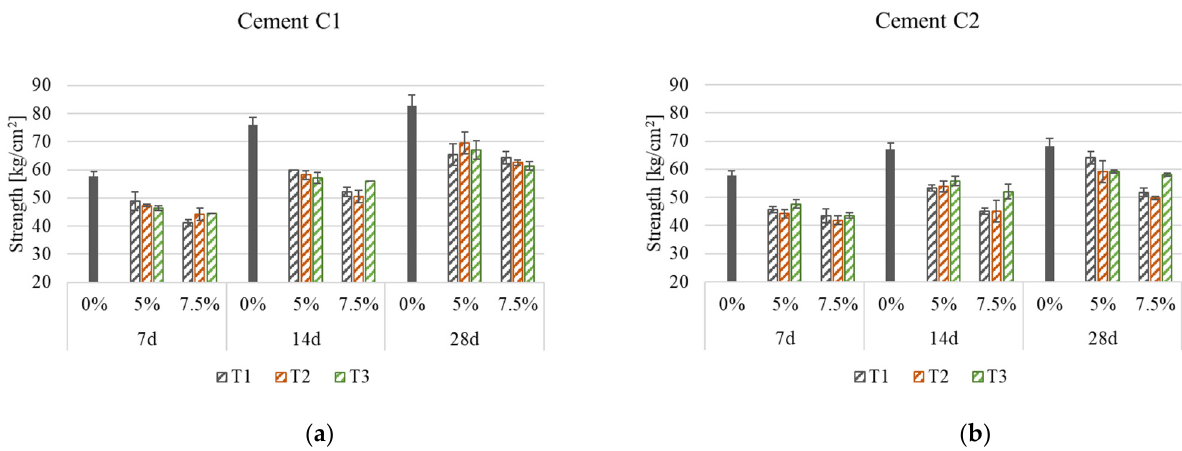
Figure 12. Flexural strength of mortar samples with addition of untreated rubber at 5% and 7.5% replacement, after 7, 14, and 28 days: ( a ) cement C1; ( b ) cement C2.